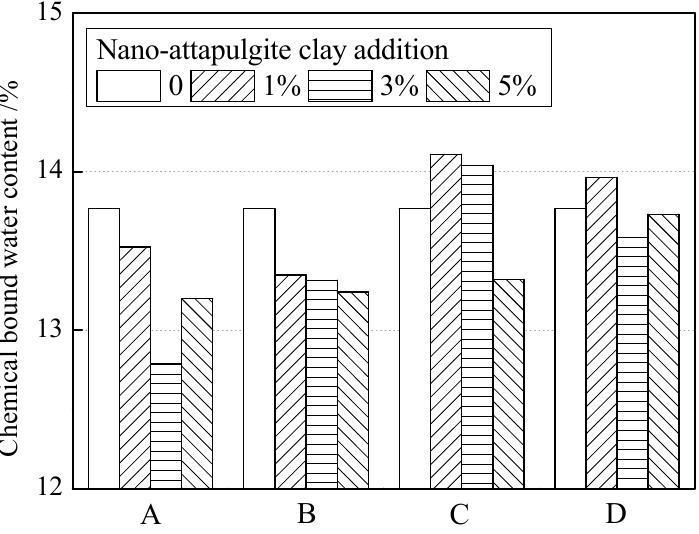
Figure 13. Chemical-binding water content of cement paste with various NAC addition. Figure 14 shows the relationship between the compressive strength of the cement paste and the chemically immobilized water content, which was positively correlated.